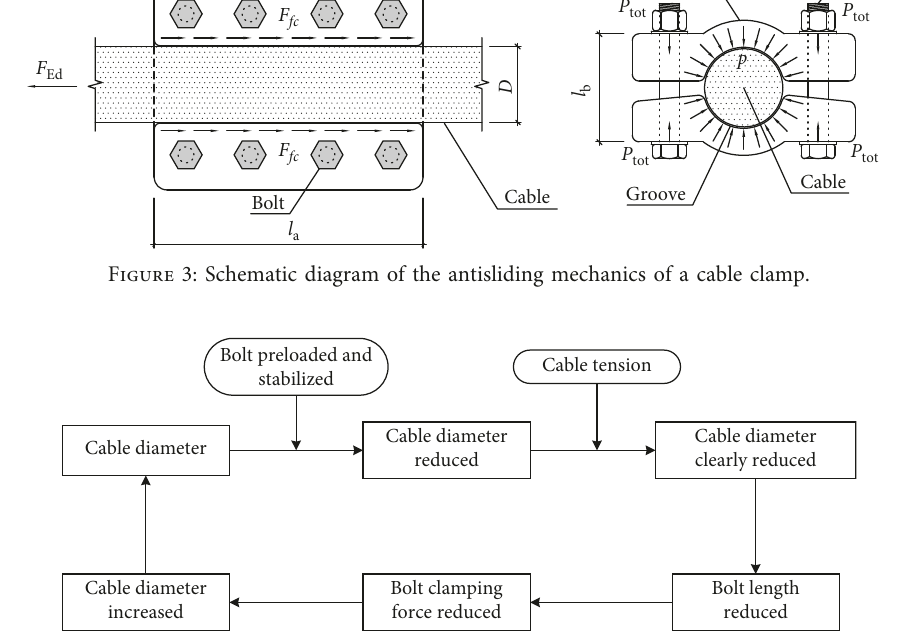
Figure 4: Relationship of bolt clamping force, cable tension, cable cross-sectional diameter, and bolt length.